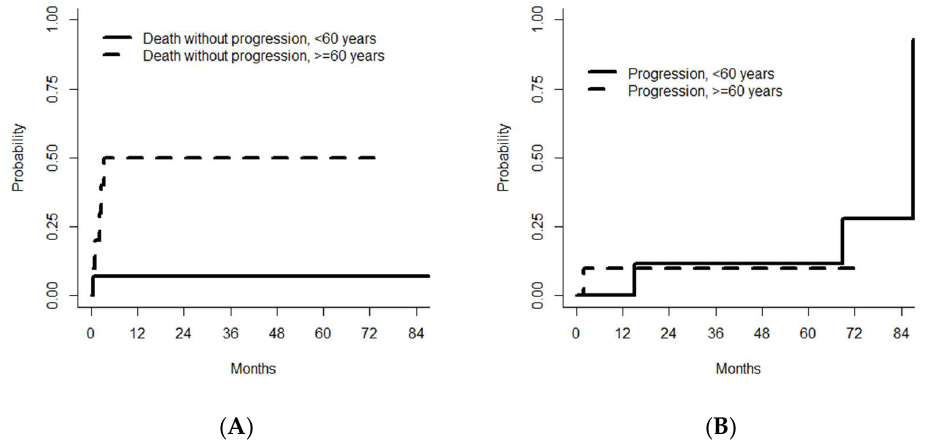
Figure 2. The PFS curves, by age. Figure 3. Cumulative incidence of death without progression (i.e., TRM) ( A ) and disease progres- sion ( B ), by age. Table 3. Competing risks analysis.